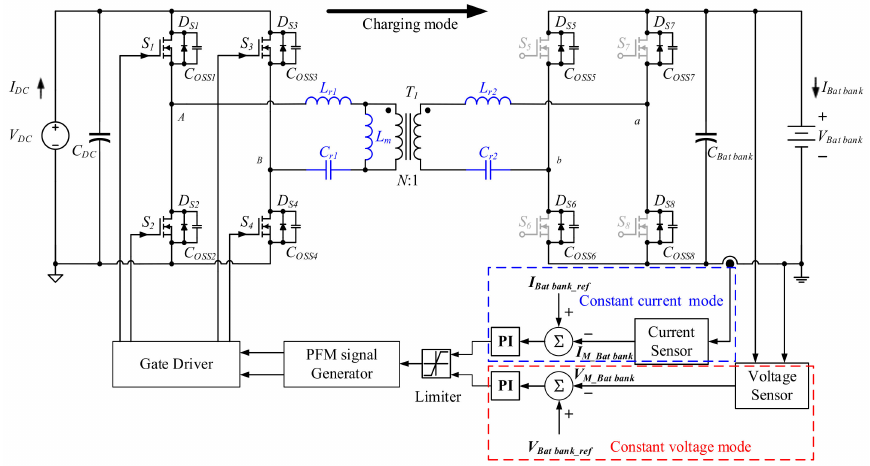
Figure 12. Control framework of the proposed bidirectional CL 3 C full-bridge resonant converter for the charging